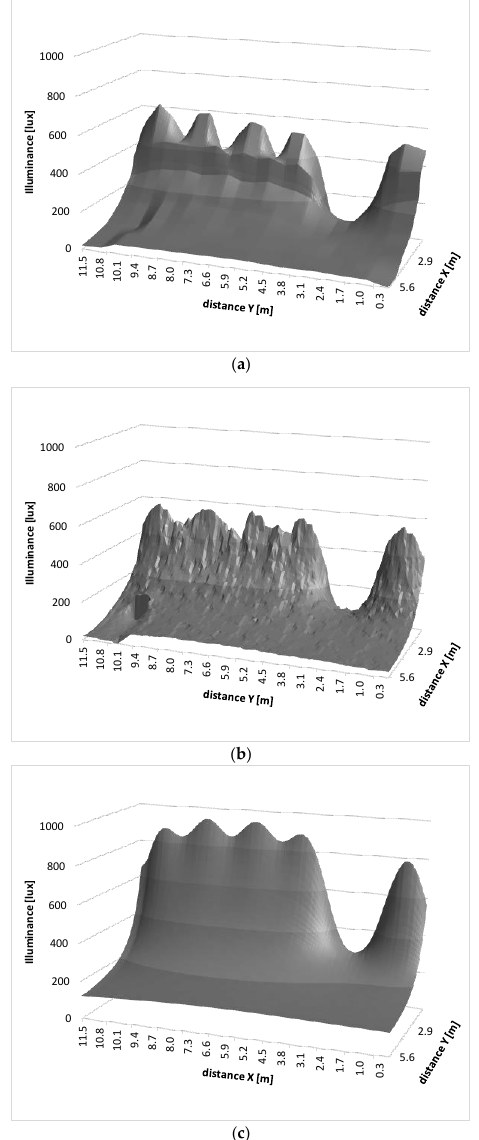
Figure 6. Illuminance distribution for cloudy conditions (11 January 2019) ( a ) measured at 8:48–9:09, ( b ) DB (Radiance) 9:00, ext. illuminance 5251 lx, ( c ) DB (EnergyPlus) 9:00, irradiation 47.68 W/m 2 .